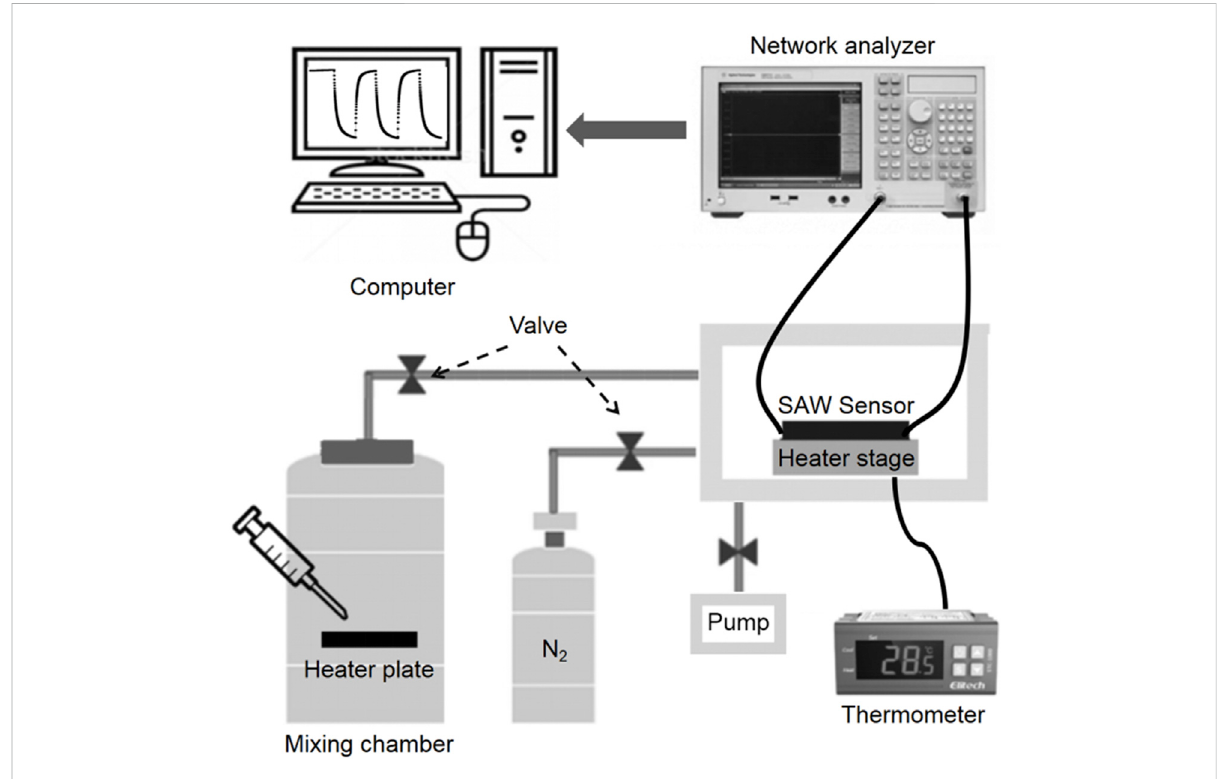
FIGURE 2 Schematic diagram of the gas sensor